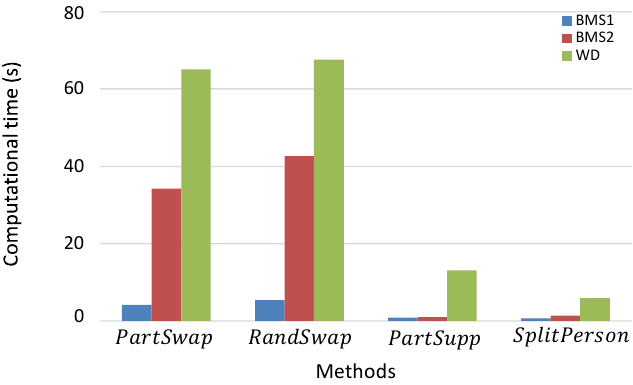
Figure 6. Required computational time to generate (cid:101) D among different